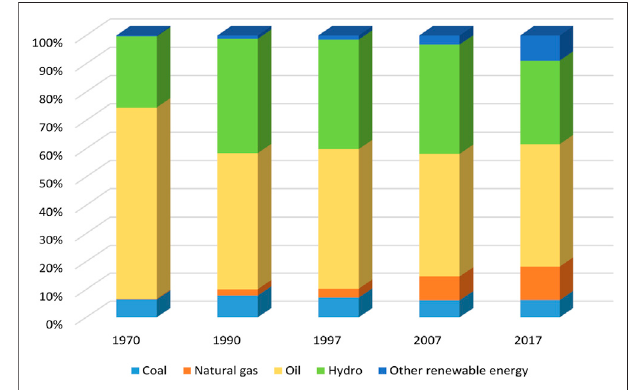
FIGURE 1 | Share of different energy consumption source in